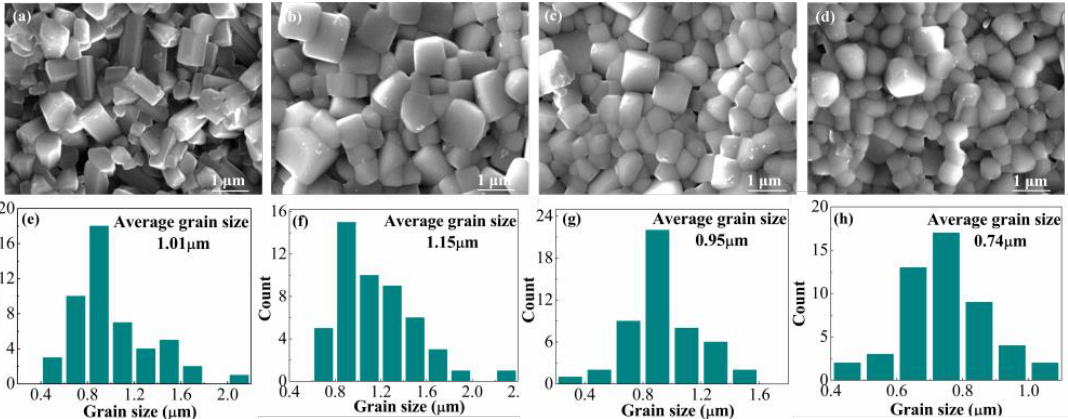
Figure 2. SEM images of surface and grain size distribution for porous BNBT6- x Sm ceramics at ( a , e ) x = 0, ( b , f ) x = 0.01, ( c , g ) x = 0.02, and ( d , h ) x = 0.04.